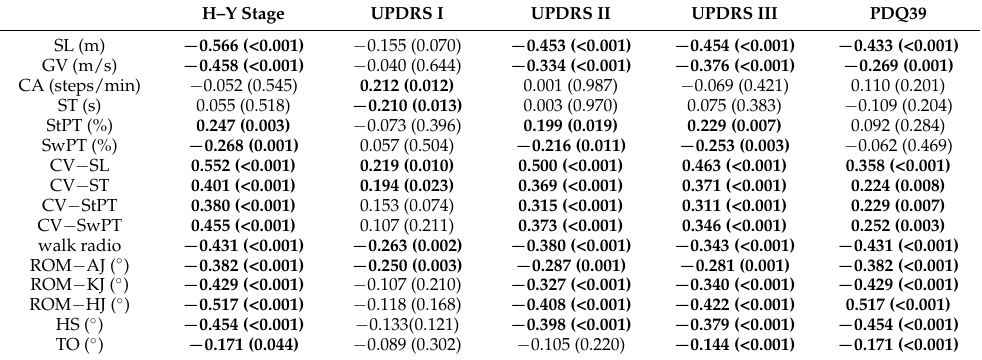
Table 2. Symmetry analysis of gait parameters.